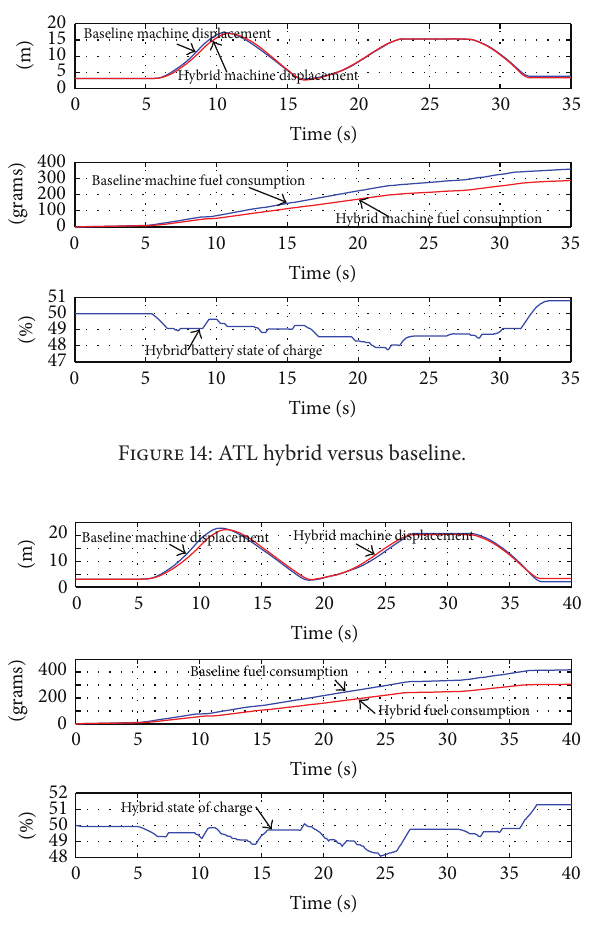
correlation with the real machine. Three work cycles were used in the analysis: ATL, MTL, and SLC cycles. Figure 14 compares between the baseline regular and the optimized hybrid wheel loader for the ATL